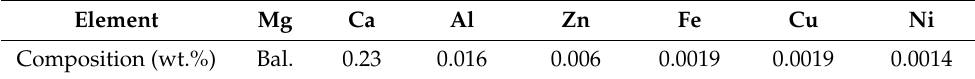
Table 1. Nominal composition of the extruded Mg-Ca0.3 alloy. Element Mg Ca Al Zn Fe Cu Ni Composition (wt.%)